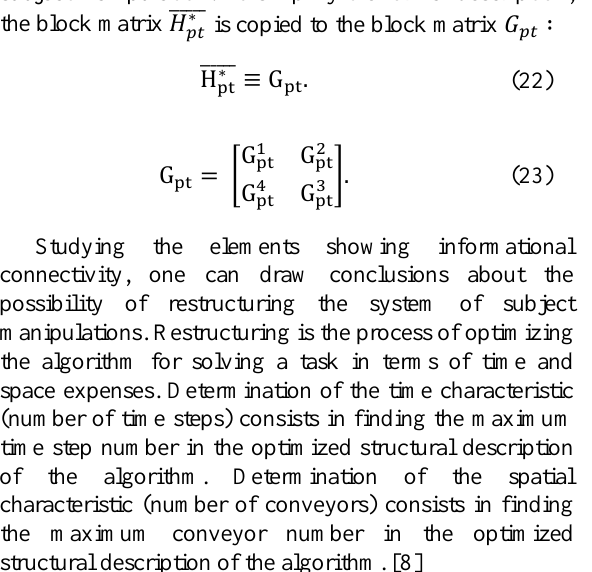
Fig. 2. Structural description of the algorithmic construction of